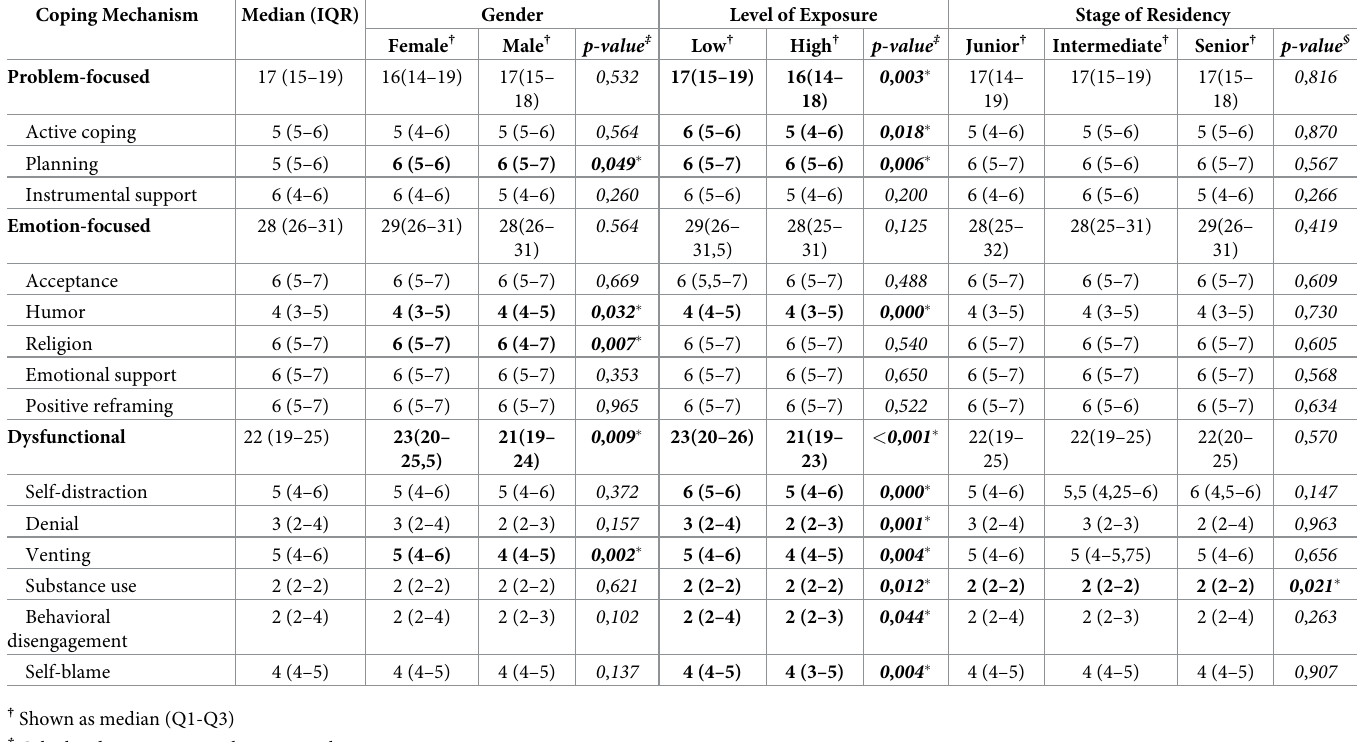
Table 2. Correlation between coping mechanism and gender, level of exposure, and stage of